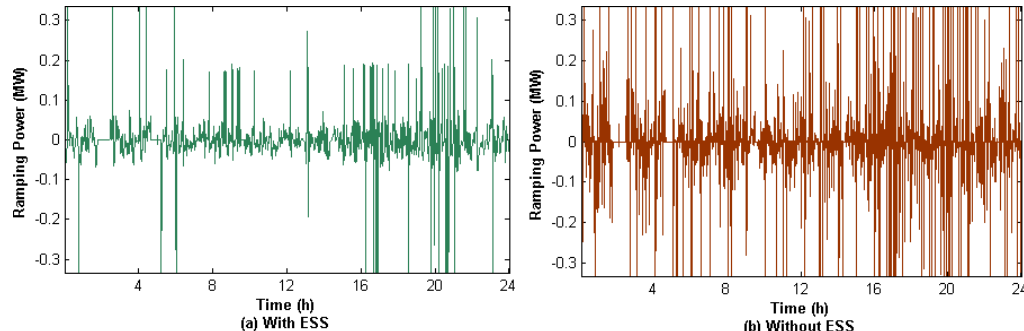
Figure 8. The generator ramping under hybrid system ( a ) and AGC system without ESS ( b ).